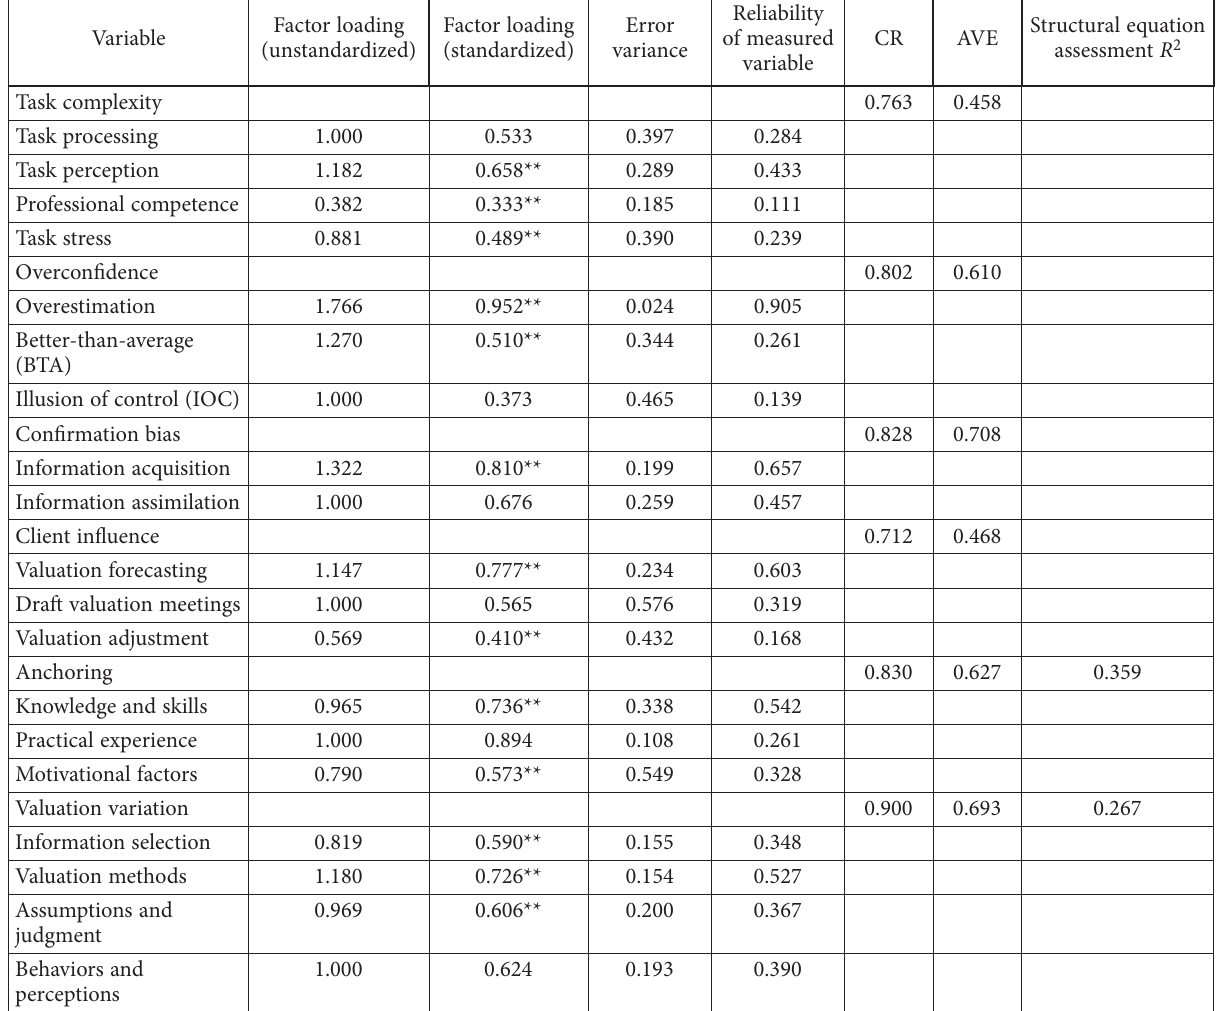
Table 3. Analysis of the questionnaire’s reliability, factor loading, and